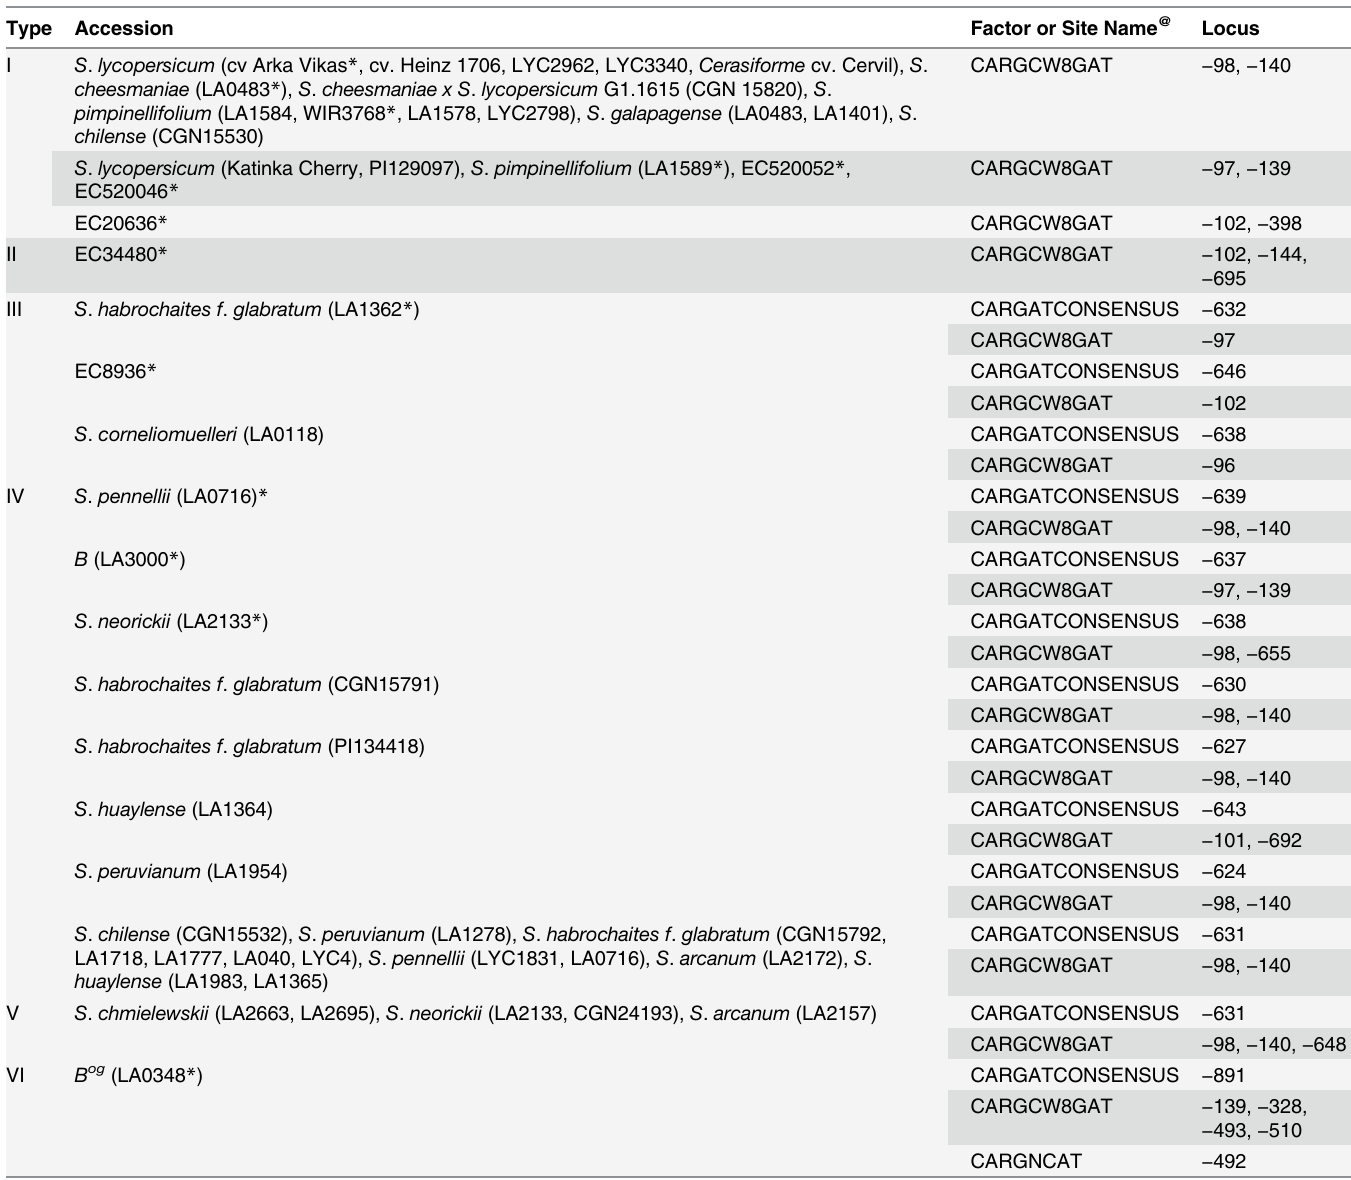
Table 1. List of RIN binding sites identified in the CYC-B promoter sequences of various accessions using PLACE Signal Scan Search. Type Accession Factor or Site Name @